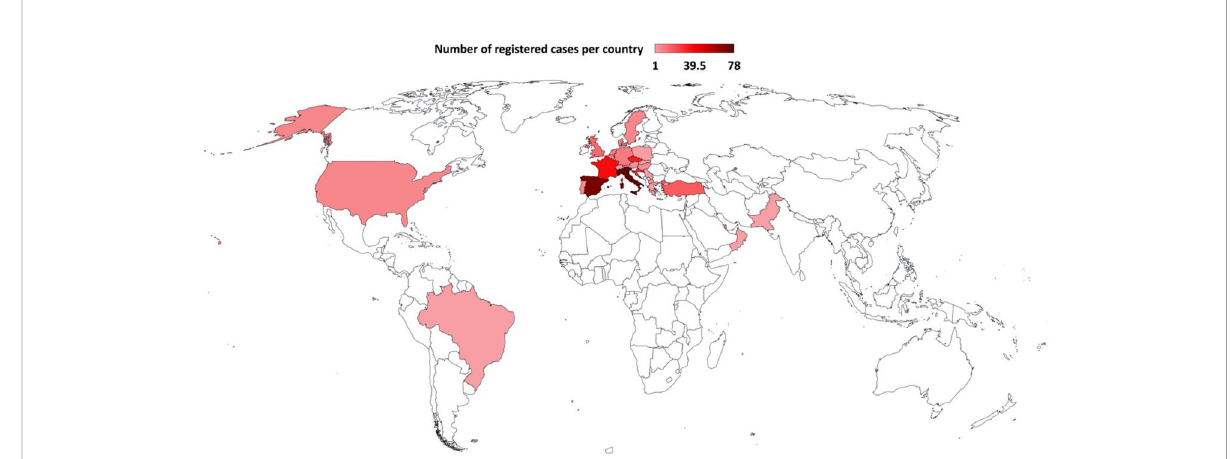
FIGURE 1 Countries contributing CLL and NHL cases to EPICOVIDEHA receiving targeted malignancy treatment, as of January 2022. Italy (n=78), Spain (n=72), France (n=37), Czech Republic (n=33), Croatia (n=27), Turkey (n=18), United Kingdom (n=14), Denmark (n=10), Germany (n=10), Netherlands (n=9), Belgium (n=8), Sweden and United States (n=7, each), Portugal (n=6), Austria, Hungary and Qatar (n=5, each), North Macedonia and Switzerland (n=3, each), Greece and Slovakia (n=2, each) and Brazil, Oman, Pakistan, Poland and Serbia (n=1,